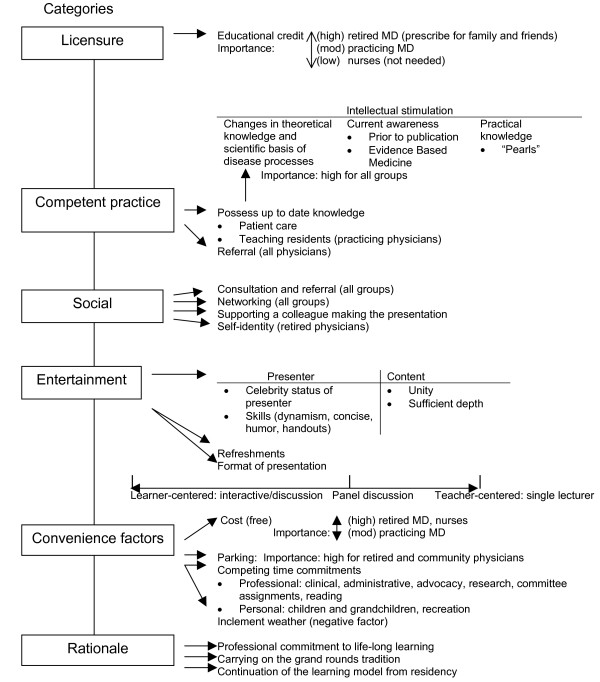
Concept map of factors affecting grand rounds attendance.